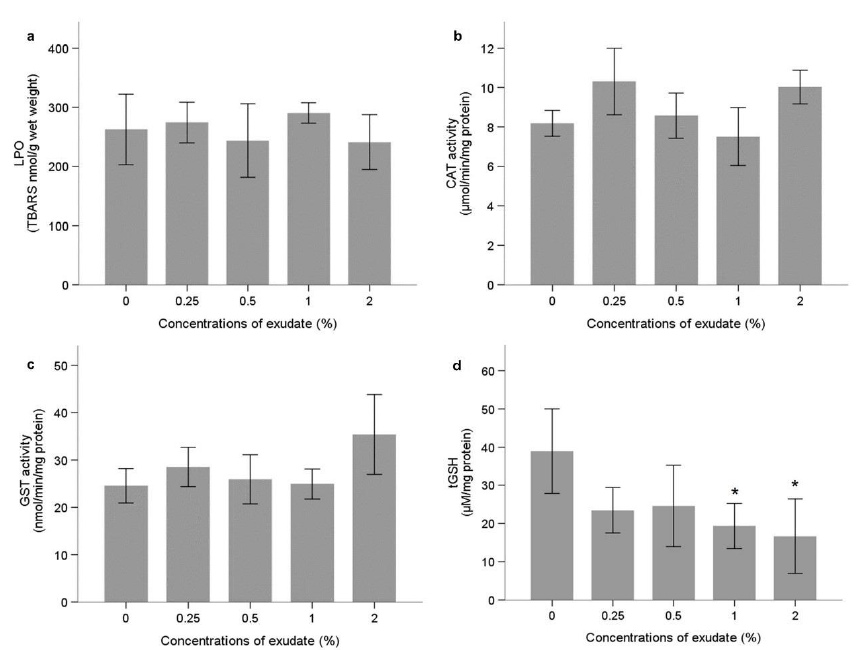
Figure 3. Oxidative stress biomarkers of M. galloprovincialis gills after 96 h of exposure to A. armata exudate. ( a ) Lipid Peroxidation (LPO); ( b ) Catalase (CAT); ( c ) Glutathione-S-Transferase (GST); ( d ) Total Glutathione (tGSH). All values are presented as mean ± SE. * denotes a statistically significant difference compared to control (0%).